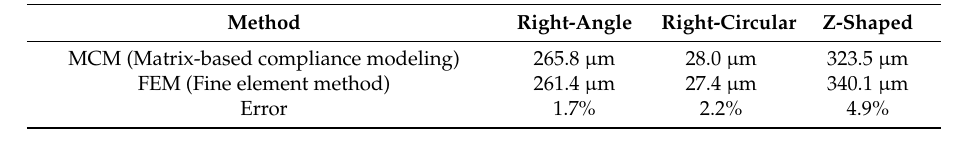
Figure 2. Comparison of FEM and MCM results for three kinds of flexure hinges.